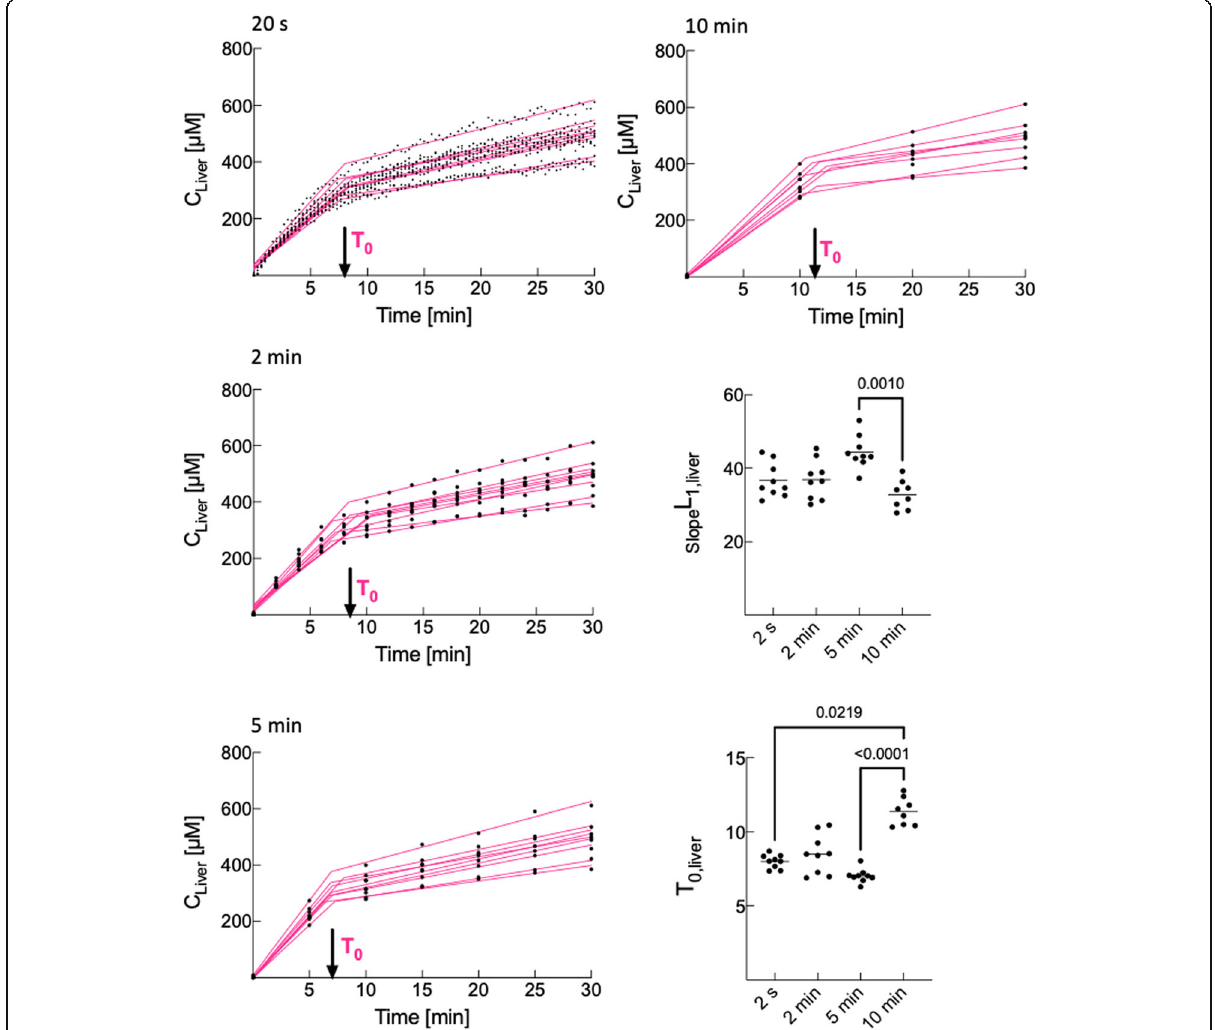
Fig. 4 Effect of acquisition frequency on pharmacokinetic parameters. We simulated lower acquisition frequencies and fitted Bopta liver concentrations with a segmental linear regression. Similar T 0 and L 1 slopes were obtained with acquisition frequency between 20 s and 5